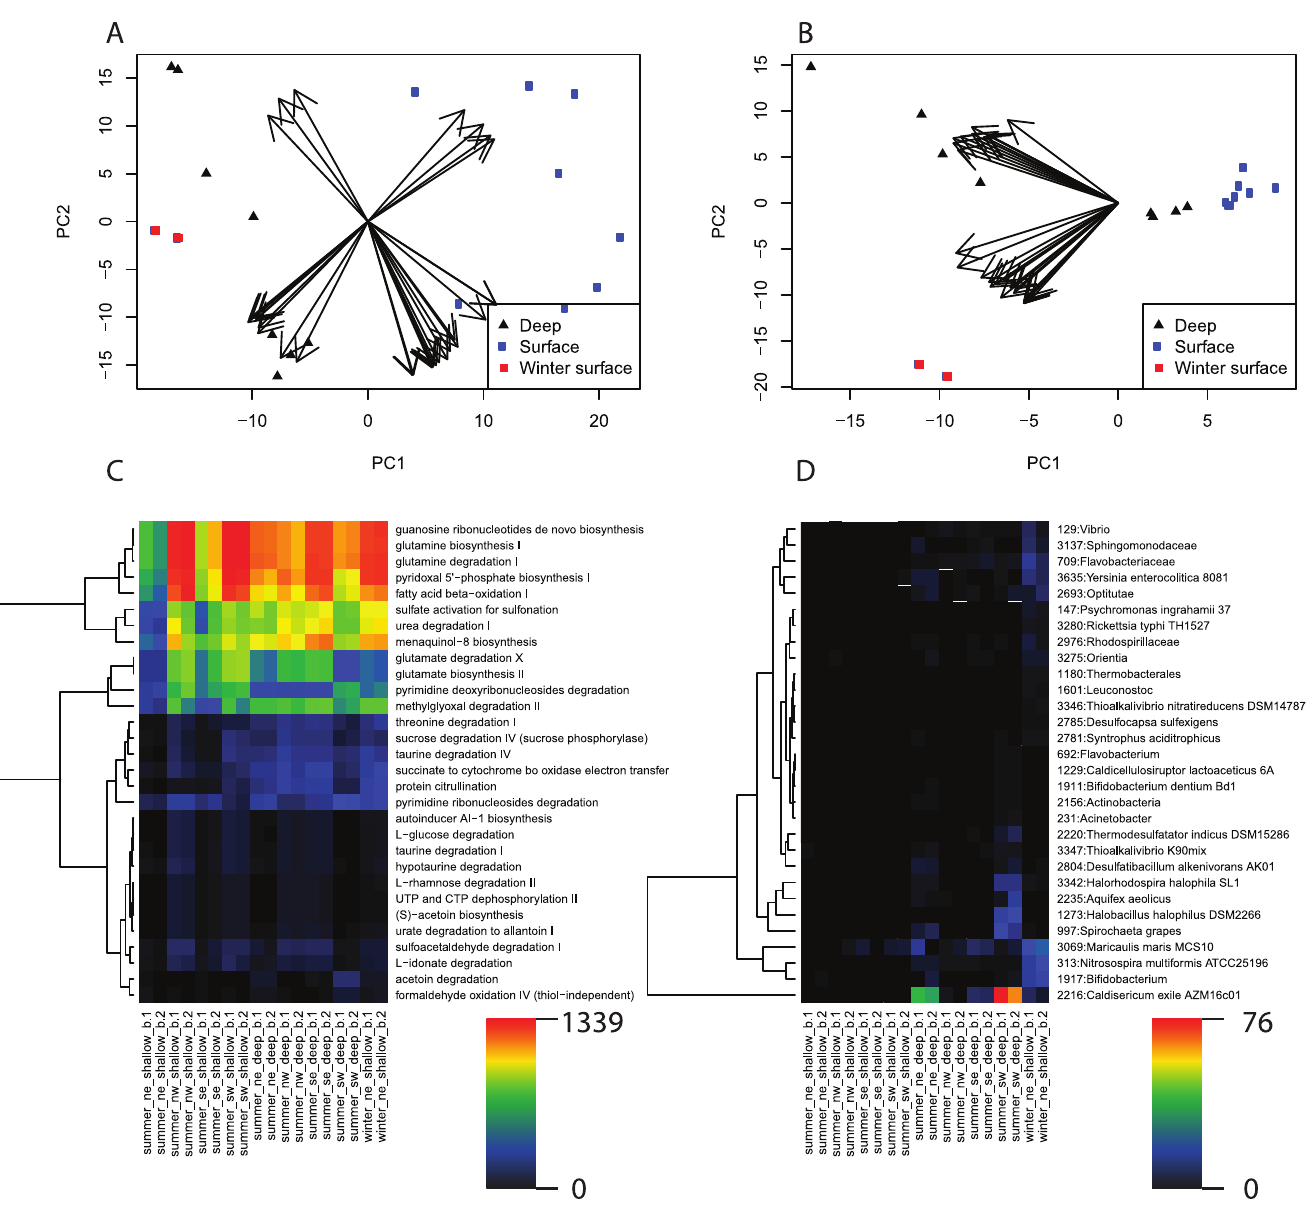
Fig 5. Metabolic pathways and edges accounting for the most variance between samples. A) PCA of normalized metabolic pathway abundance (see text). Arrows are vectors for the top twenty pathways ordered by their magnitude in PC1 and PC2. B) Heatmap of abundance for the top twenty pathways ordered by their magnitude in PC1 and PC2. Hierarchical clustering on the y-axis uses the defaults of the heatmap command in R; Euclidean distance and the complete linkage clustering method. C) PCA of normalized edge abundance (see text). Arrows are vectors of the top twenty edges ordered as for A. D) Heatmap of abundance for the top twenty edges ordered as for B. Hierarchical clustering on the y-axis is as for B. Values on the color bar are raw (not normalized)